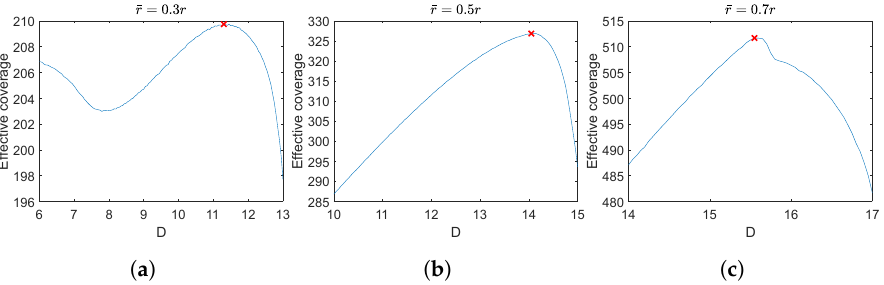
Figure 6. Team’s effective coverage vs. separation D under three different thresholds: ( a ) ¯ r = 0.3 r , ( b ) ¯ r = 0.5 r , ( c ) ¯ r = 0.7 r . Nodes are equipped with concave models. r = 10. α = 1. The red cross in each plot marks the maximum effective coverage.